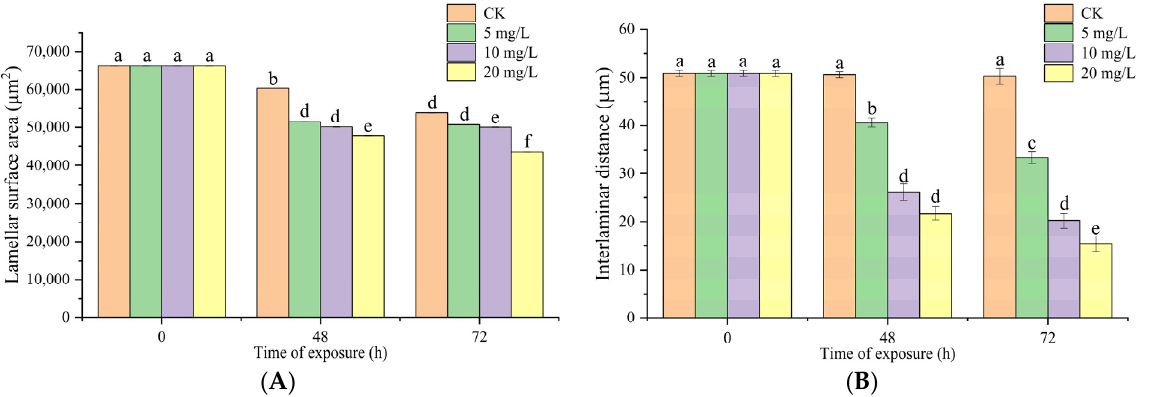
Figure 7. Quantification of fish gill structure. Lamellar surface area of gill ( A ) and interlaminar distance of gill ( B ) in grouper. Different lowercase letters indicate that there are significant differences among groups ( p < 0.05).